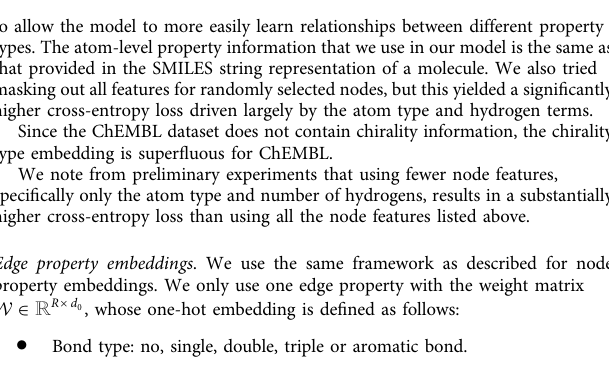
Fig. 4 Model architecture. A description of the node and edge features is given in the Property Embeddings part of the Methods